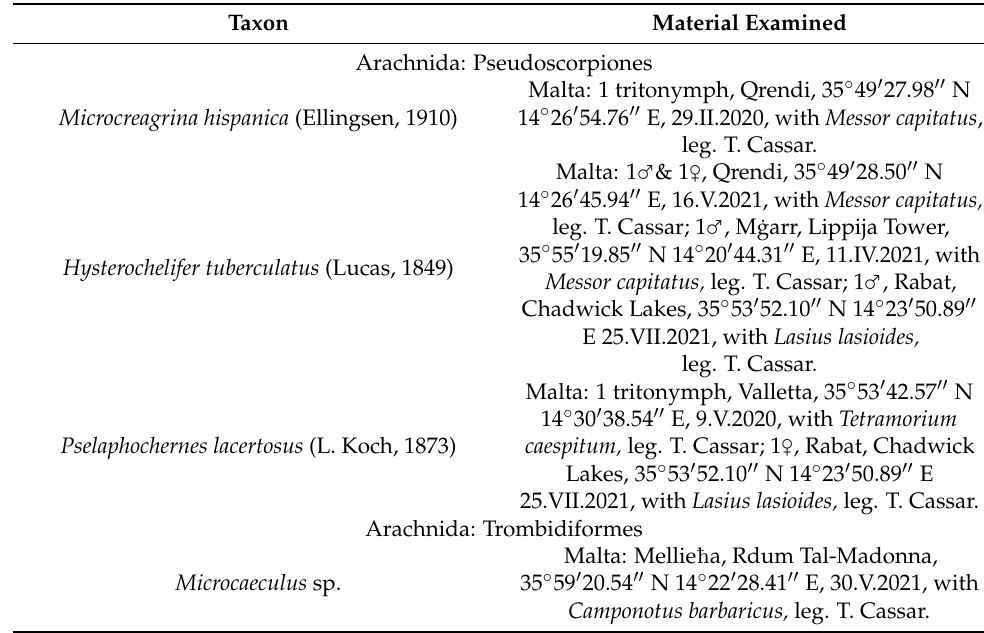
Table A2. Taxa whose presence in ant nests is considered only occasional or purely accidental, or whose myrmecophilous status is otherwise ambiguous 1